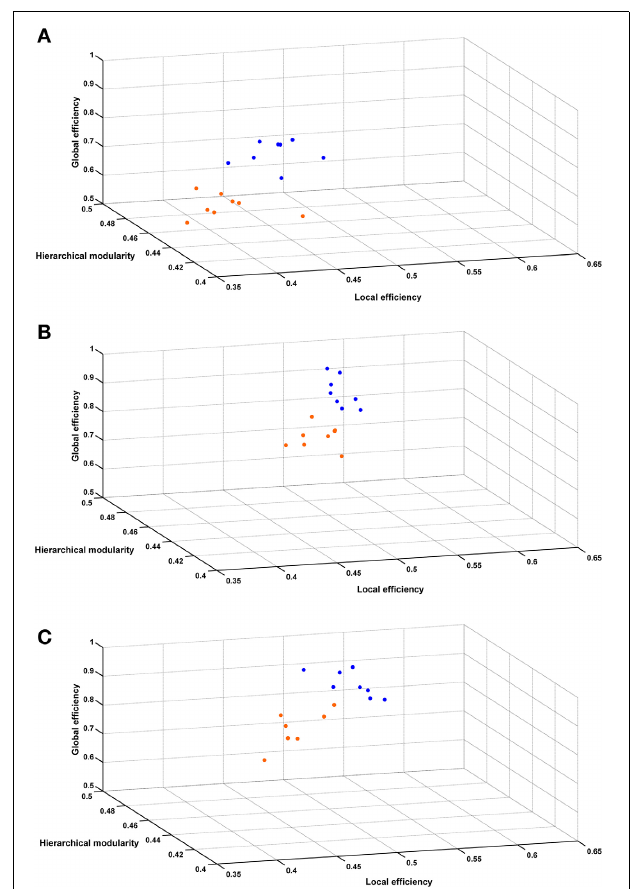
FIGURE 6 | Hierarchical modularity, global and local efficiency indices. Three-dimensional scatter plots of all animals represented by their connectivity indexes at (A) 10 weeks, (B) 22 weeks, (C) 40 weeks. Blue dots represent control animals and orange dots represent